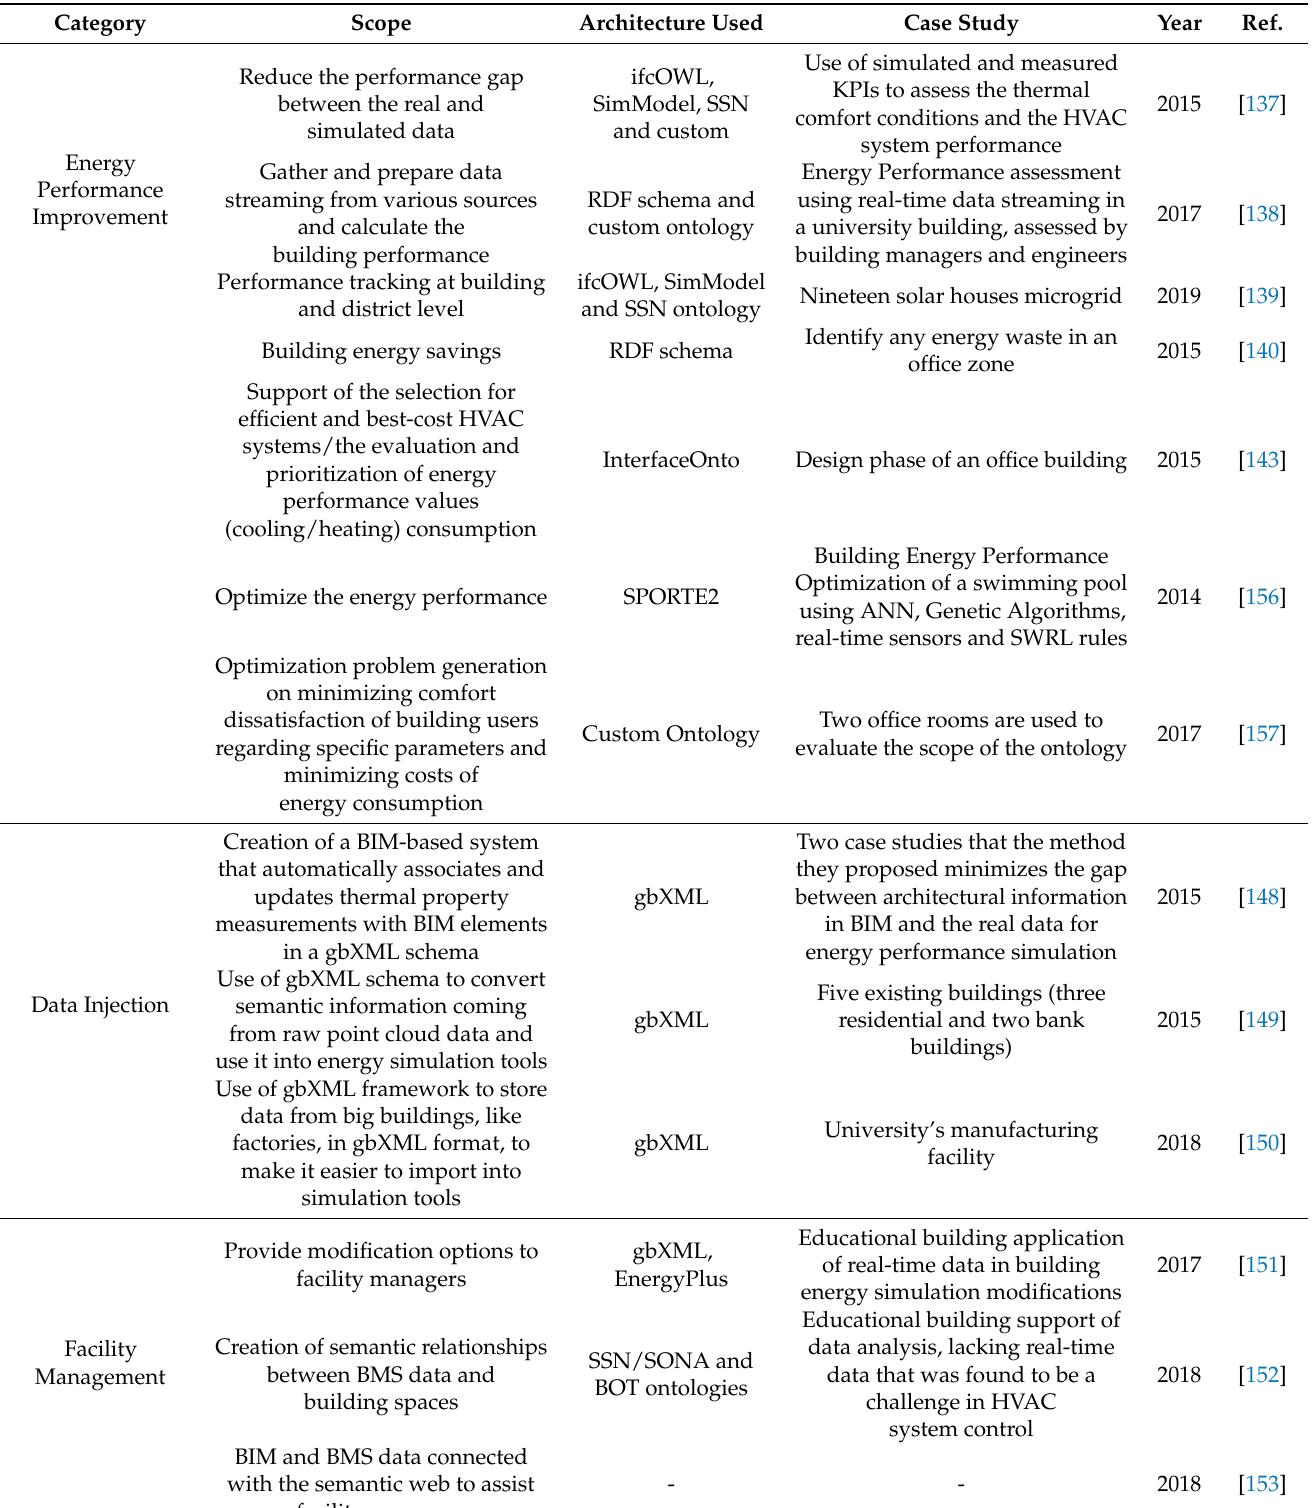
Table 2. Applications of ontologies in